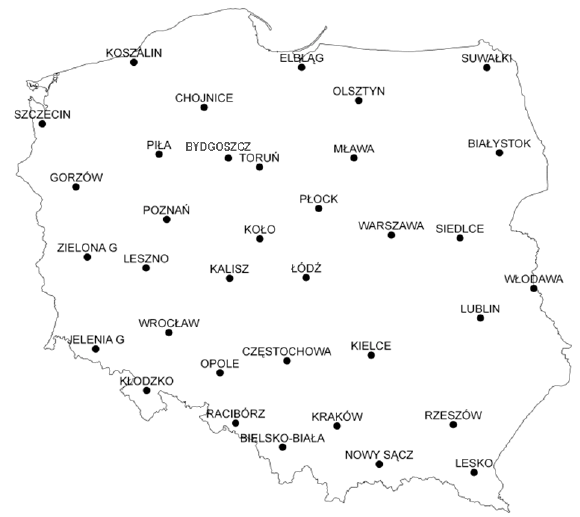
Figure 1. Location of precipitation stations.